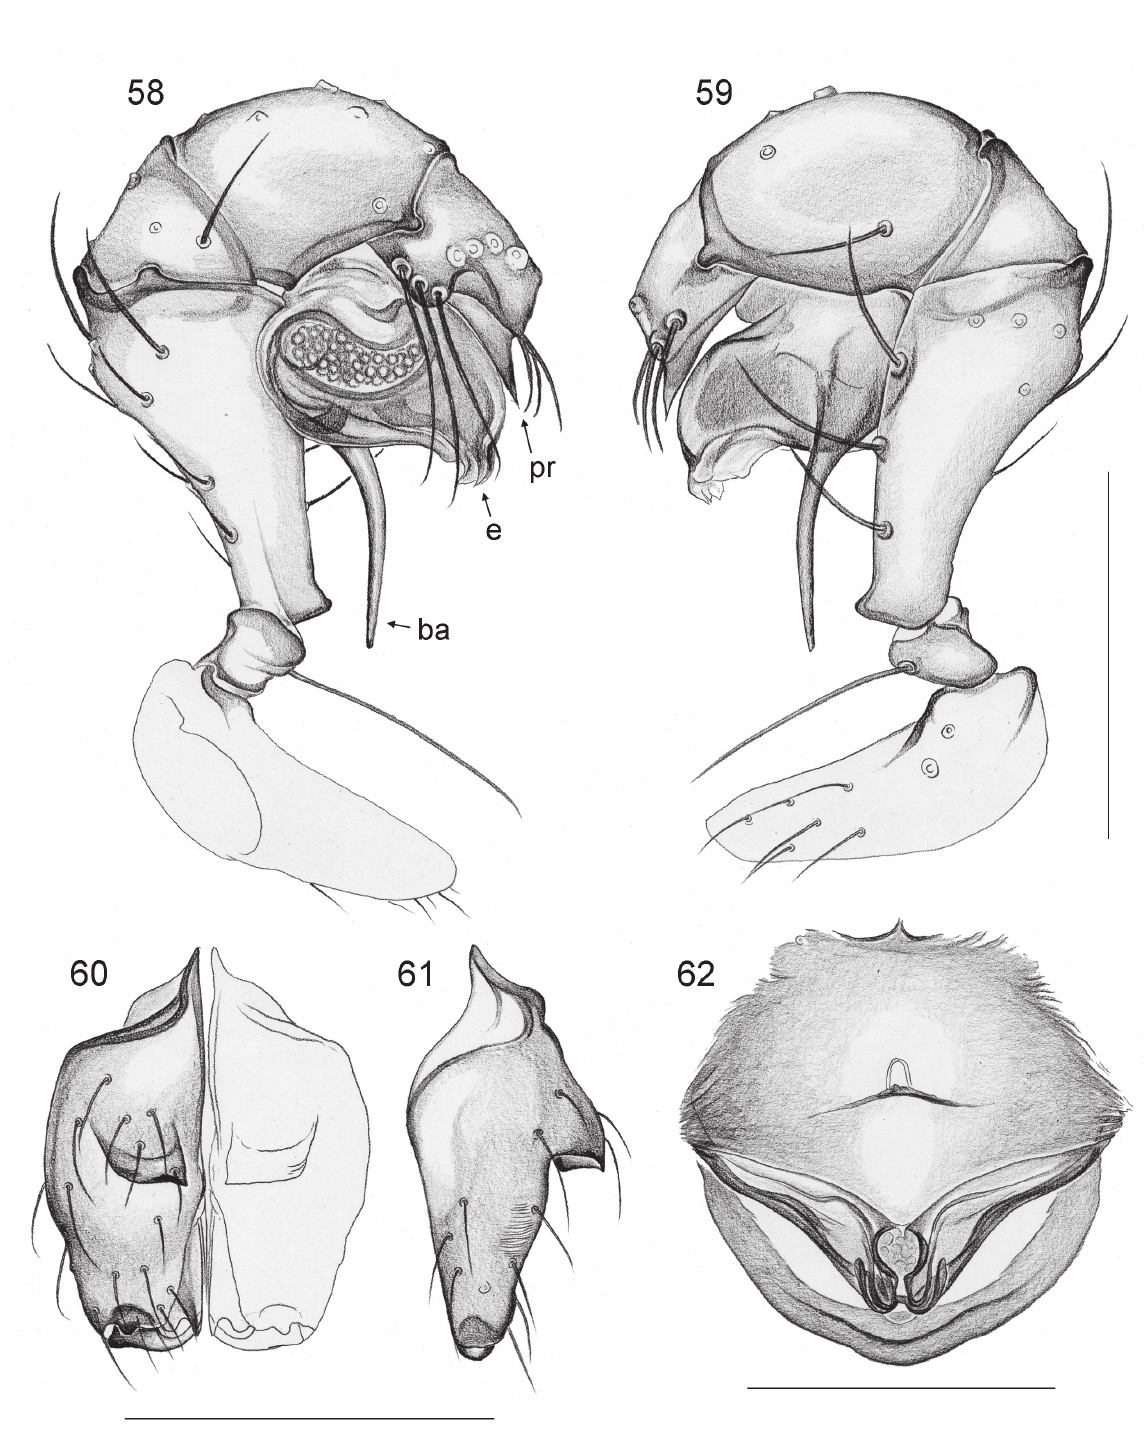
Figs 58-62. Ninetis faro sp. nov. 58-59 . Left ♂ palp, prolateral and retrolateral views. 60-61 . ♂ chelicerae, frontal and lateral views. 62 . Cleared ♀ genitalia, dorsal view. ba = bulbal apophysis; e = embolus; pr = procursus. Scale lines: 0.2